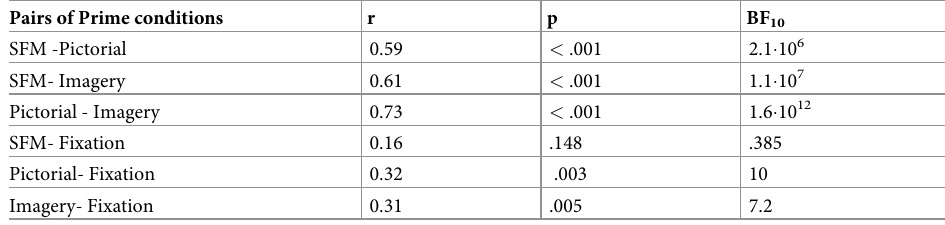
Table 2. The Pearson correlations between priming conditions in Experiment 1 (two tailed tests, N =